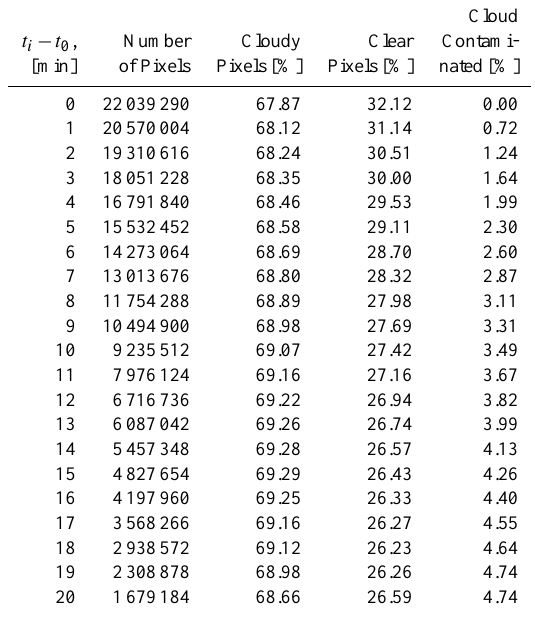
Table 2a. Statistics for Case A from GOES-10. Table 2b. Statistics for Case B from